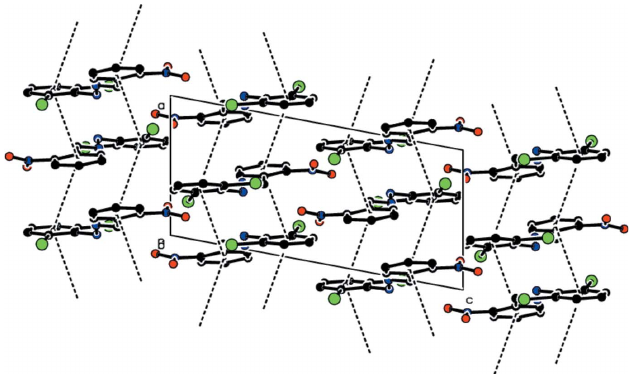
Figure 3 A partial view of (cid:2) – (cid:2) stacking interactions in the crystal packing of the title compound viewed along the b axis.